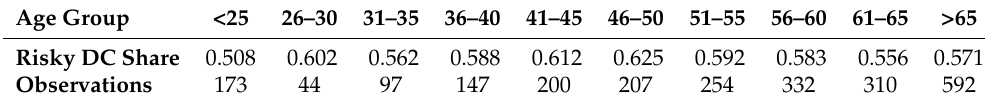
Table 2. Distribution of Risky Shares of DC Plans Across Ten Age Groups for Men in the 2019 SCF.